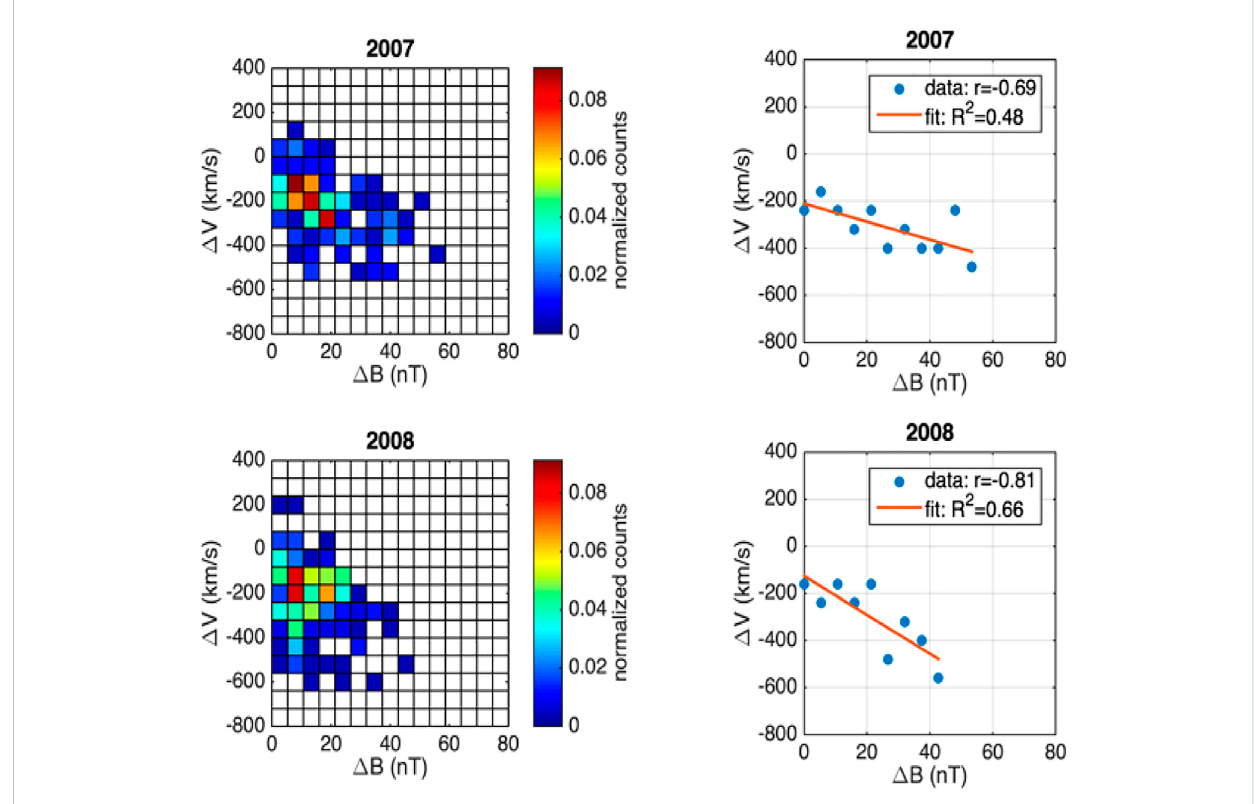
FIGURE 14 Same as Figure 13 but for the background magnetosheath